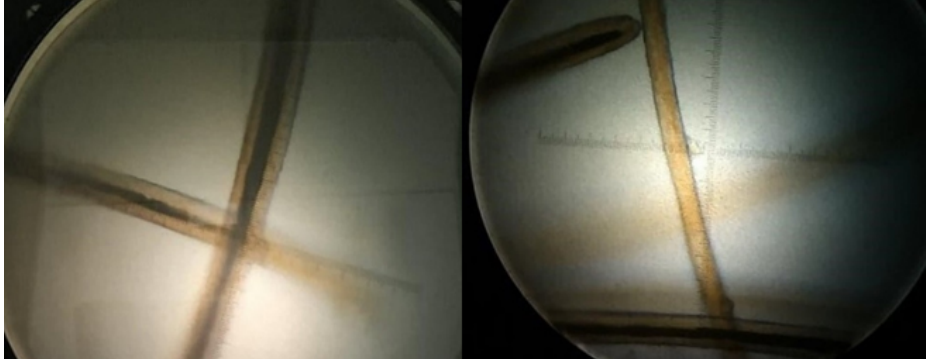
Figure 1. Fiber sample under a projection microscope during the fiber categorization